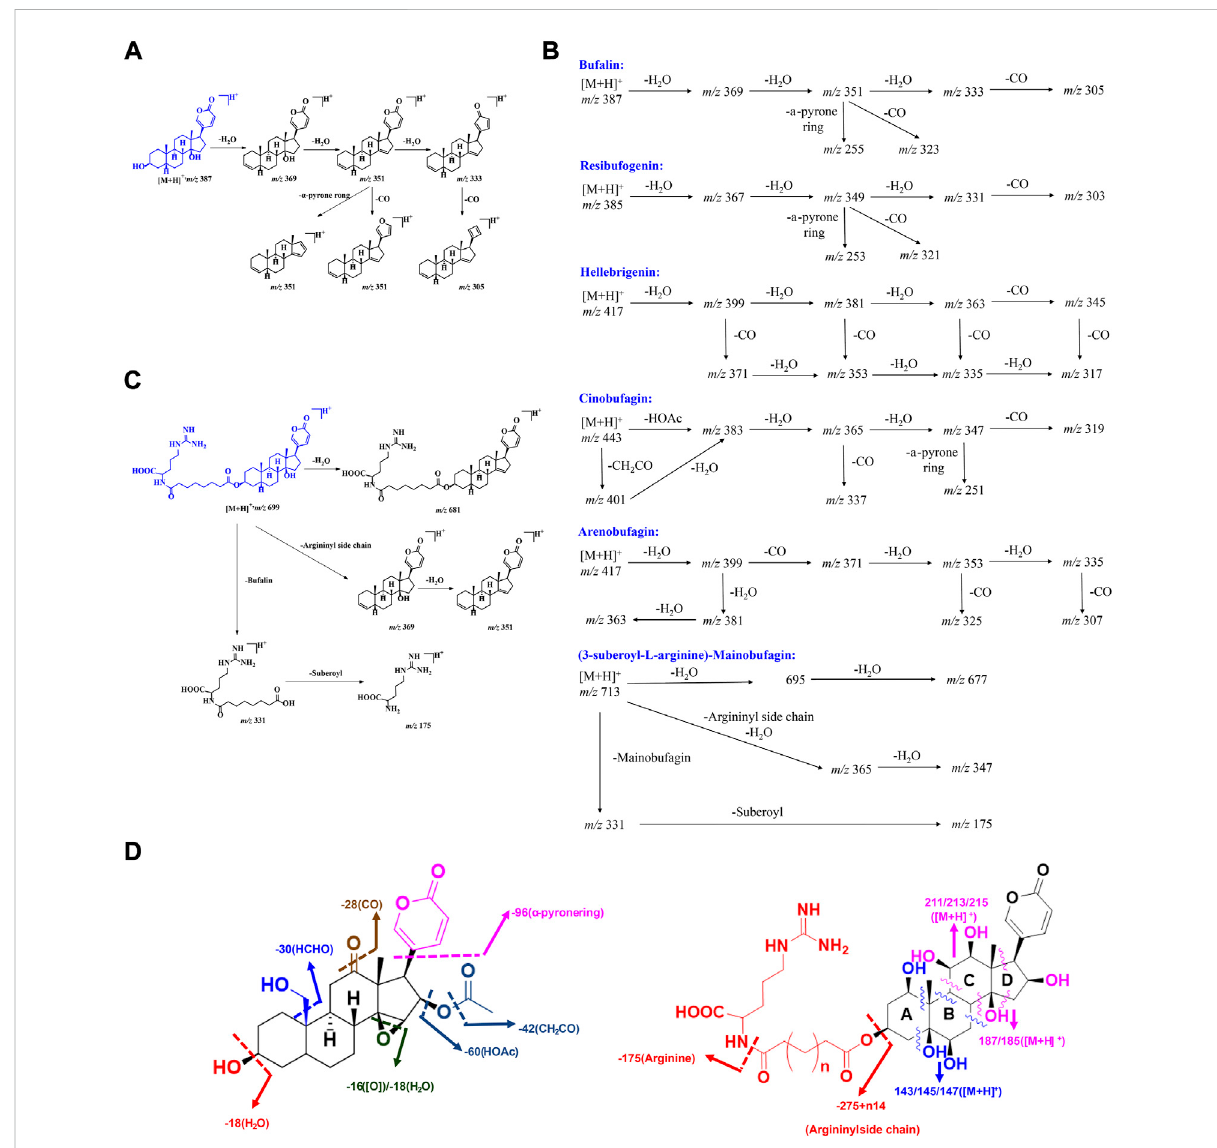
FIGURE 4 The MS fragmentation principles of bufadienolide: (A – C) The typical fragmentation pathways of free and conjugated bufadienolide; (D) The summarized fragmentation patterns of free and conjugated bufadienolide.